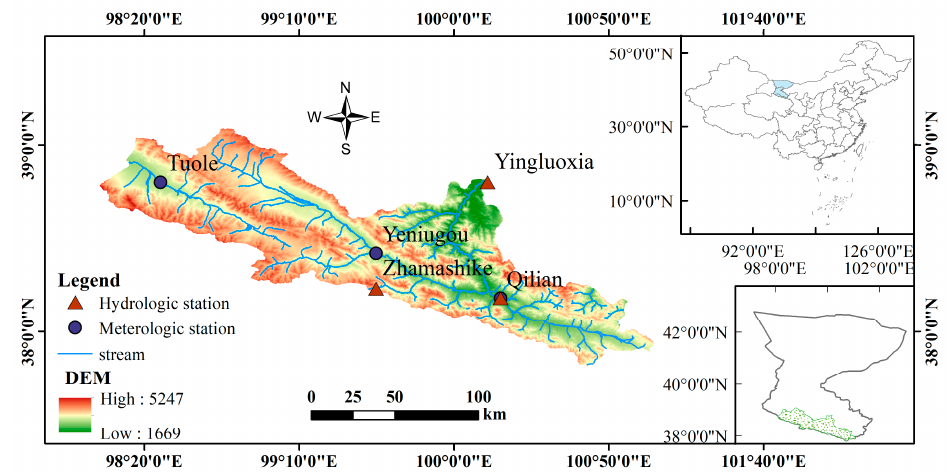
Figure 1. Upper reaches of the Heihe River Basin. The red triangles correspond to three hydrologic stations. The blue circles represent the meteorologic stations in the upper reaches of the Heihe River Basin.